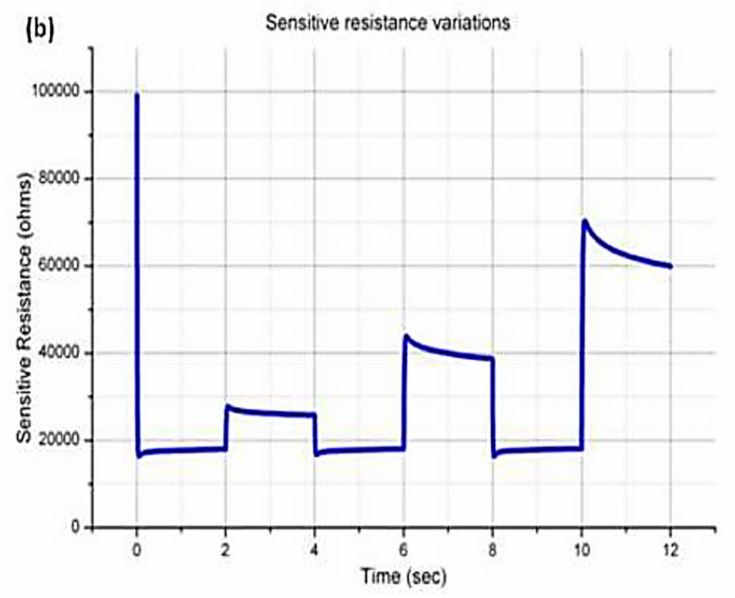
Figure 4. Power profile applied to the heater ( a ) and example of sensitive resistance variations under air ( b